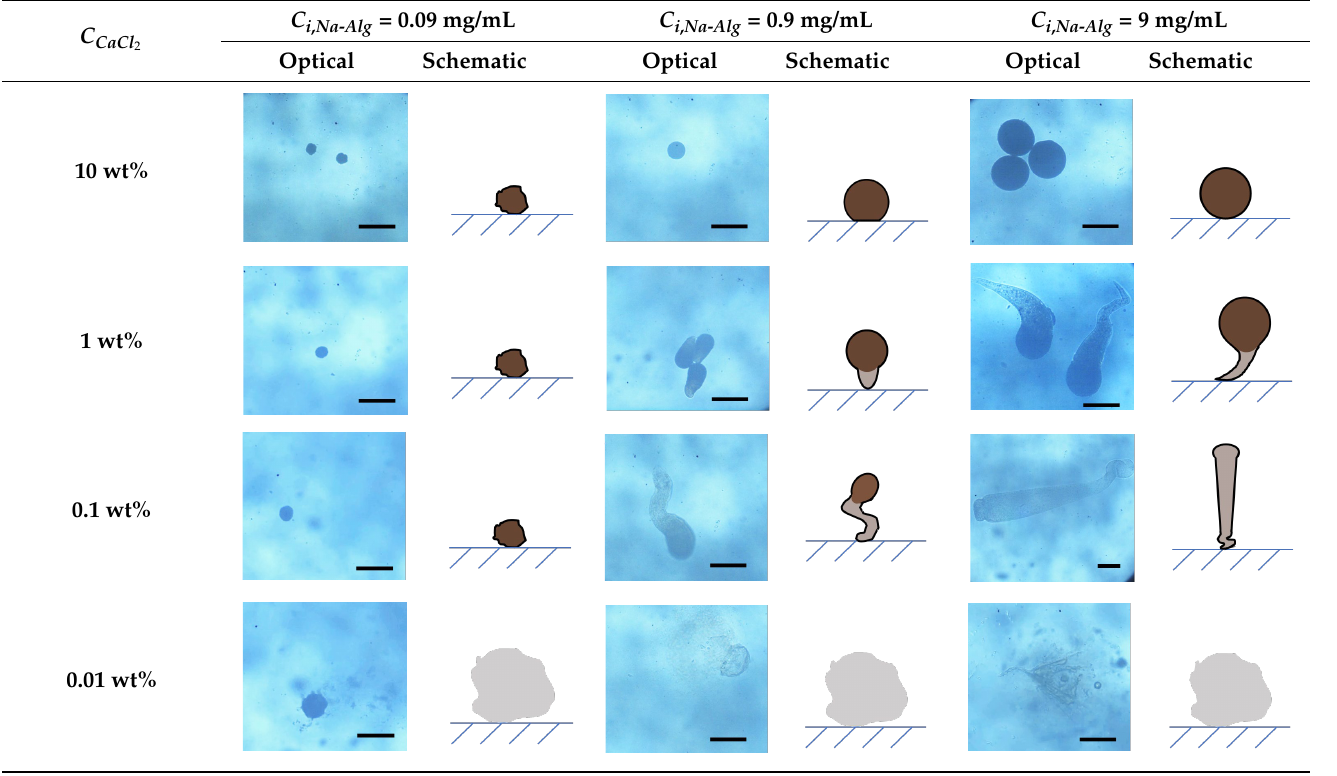
Table 2. Optical microscopic and schematic images of Ca-Alg/Fe 3 O 4 micromotors with the indication of C i , Na - Alg and C CaCl for the preparation. Scale bar 100 µ m.